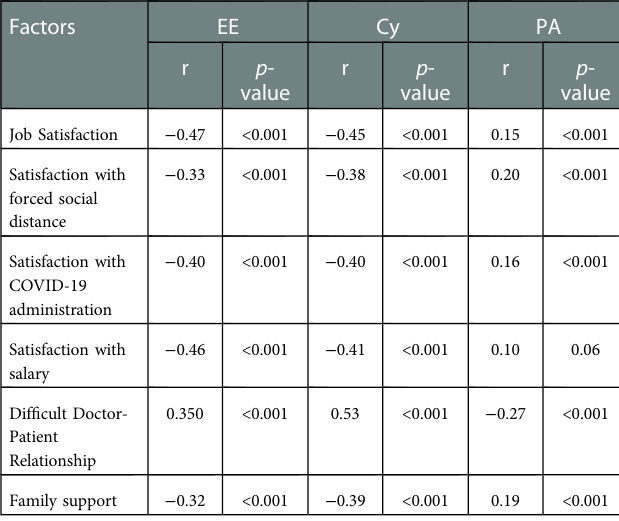
TABLE 4 Correlation analysis between related factors and